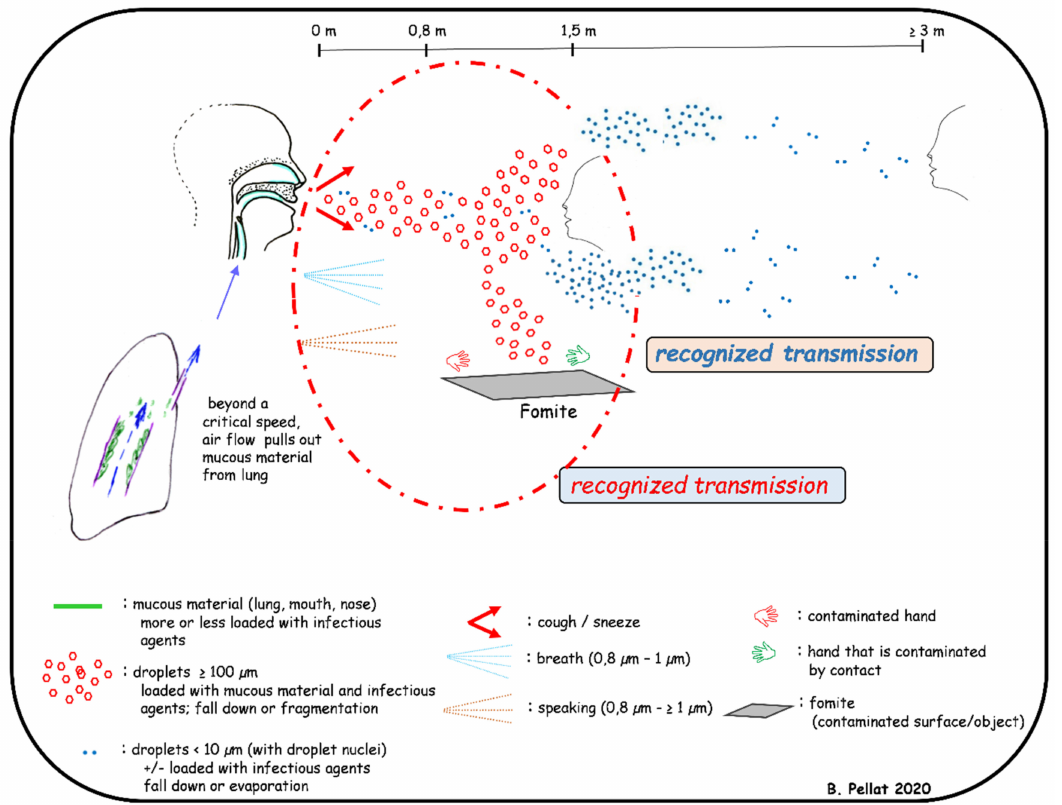
Figure 2. Aerosolization mechanisms of oral and nasal